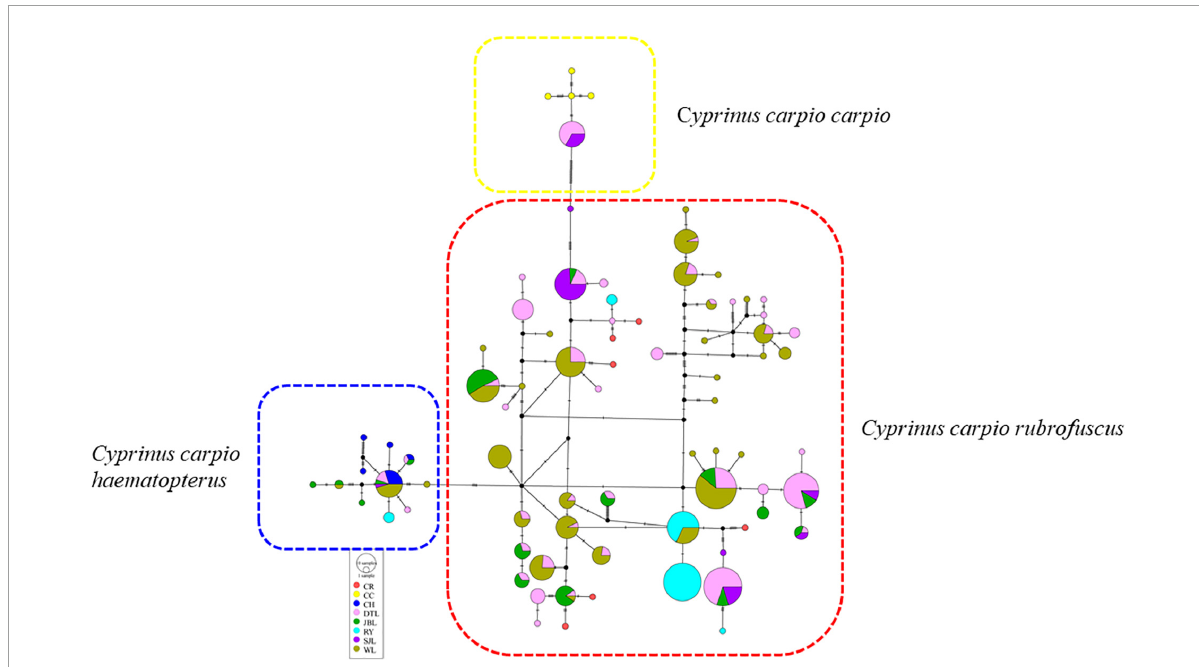
FIGURE3 Haplotype network of five strains and three subspecies, including Cyprinus carpio carpio (CC), Cyprinus carpio haematopterus (CH) and Cyprinus carpio rubrofuscus (CR). Cycle size is roughly proportional to the haplotype frequency. DTL, Daotian carp; RY, Ru Yuan No. 1; JBL, Jinbian carp; SJL, Shaijiang carp; WL, Wu